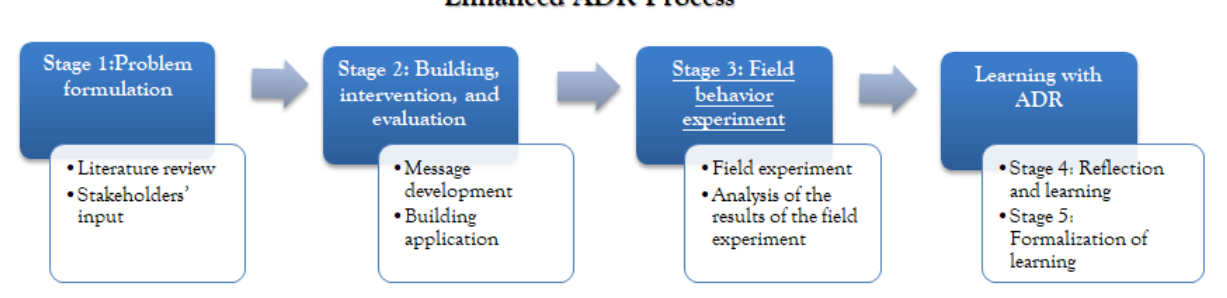
Figure 1. Research process—enhanced action design research process. ADR: action design